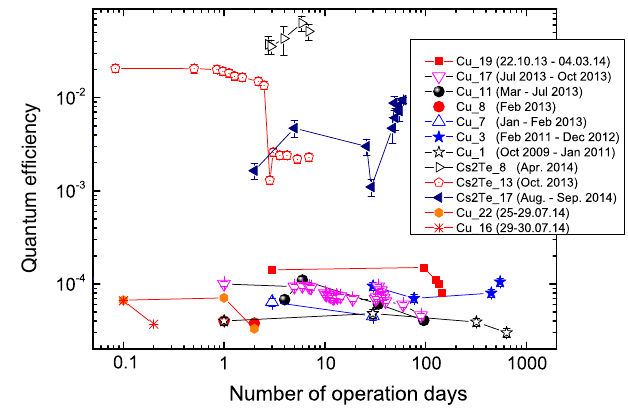
FIG. 8. Quantum efficiency evolution of the cathodes used at the SITF between October 2009 and September